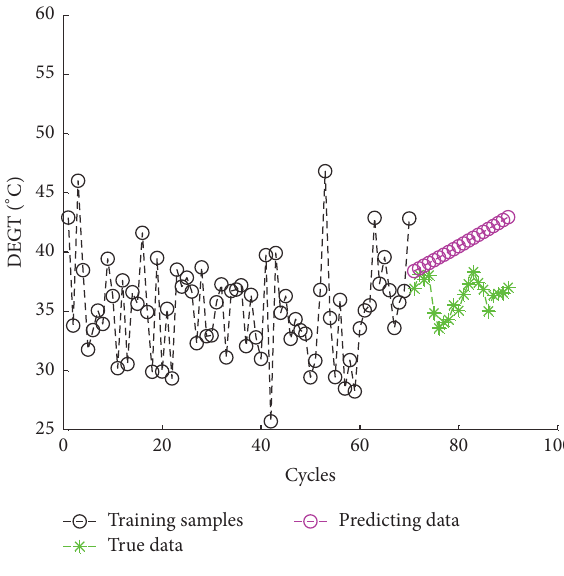
Figure 3: Prediction results of